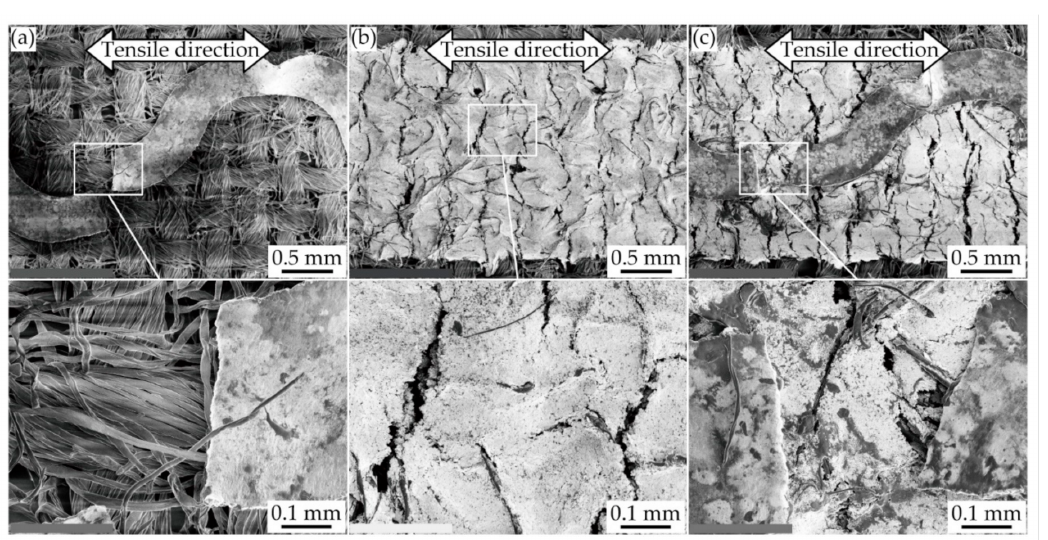
Figure 7. SEM images of conductive patterns after single tensile deformation; ( a ) meandering copper; ( b ) silver ink; and ( c ) double-layered